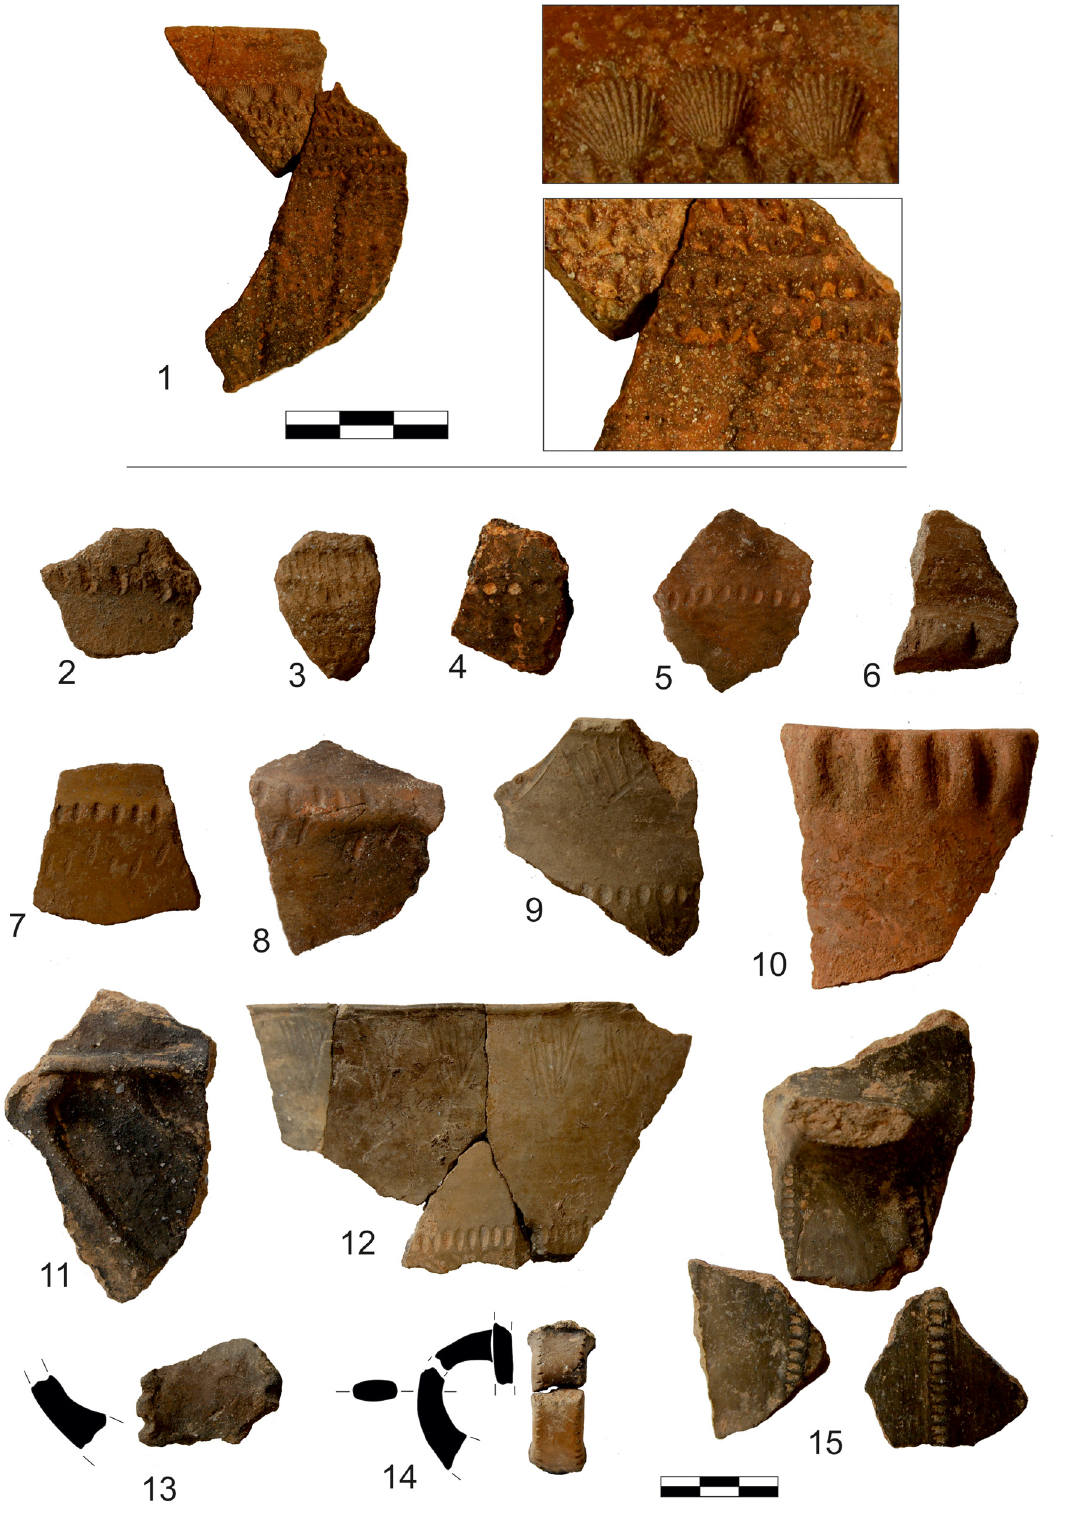
Figure 4: Selection of ceramic fragments with possible epicardial ascription. ( 1 ) Cardial impression; ( 2 and 6 ) fi nger impres - sions; ( 3 – 5 and 7 – 8 ) tool impressions; ( 9 and 12 ) incised impressions; ( 10 and 11 ) cords; and ( 13 – 15 ) ribbon handles with